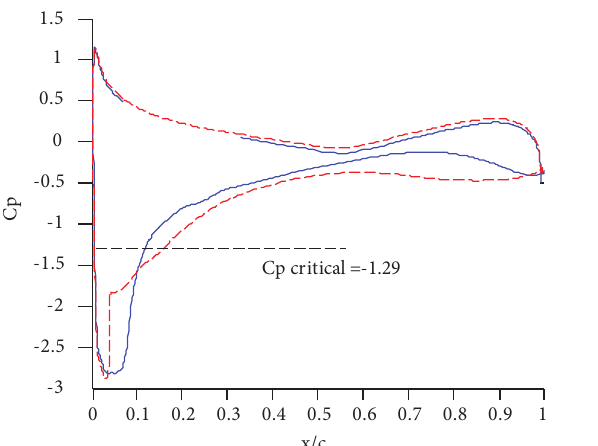
Figure 31. Pressure Coefficient distribution over the airfoil obtained from numerical solution, Mach = 0.6.